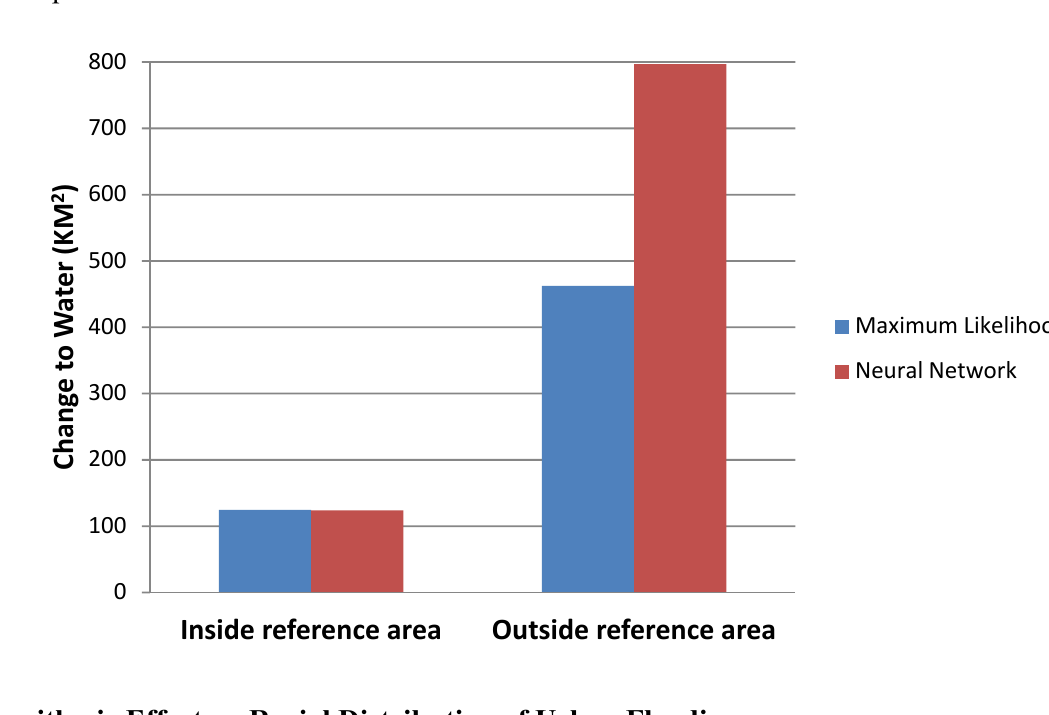
Figure 6. Flooding estimation from the two classifiers, inside and outside the reference sample